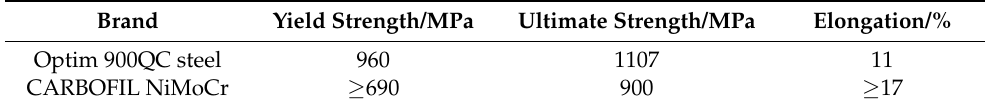
Table 2. Mechanical properties of the base metal and welding wire.